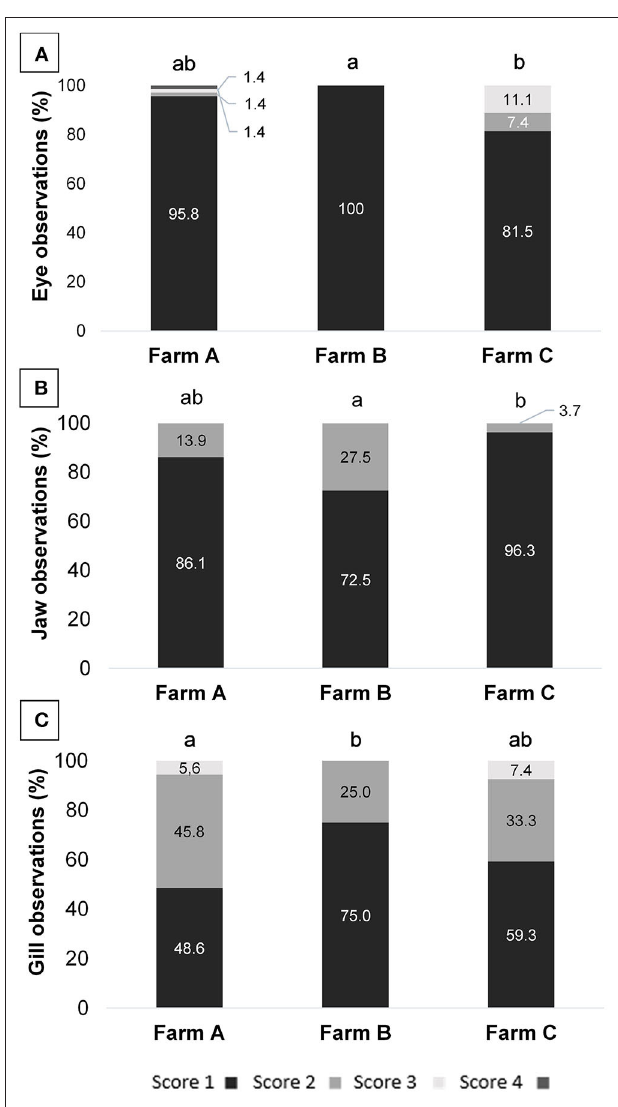
FIGURE 1 | (A) Eye, (B) jaw, and (C) gill scores assessment of tilapia from three different fish farms; different letters indicate significance obtained by Kruskal-Wallis test ( p = 0.011; 0.015; and 0.043,